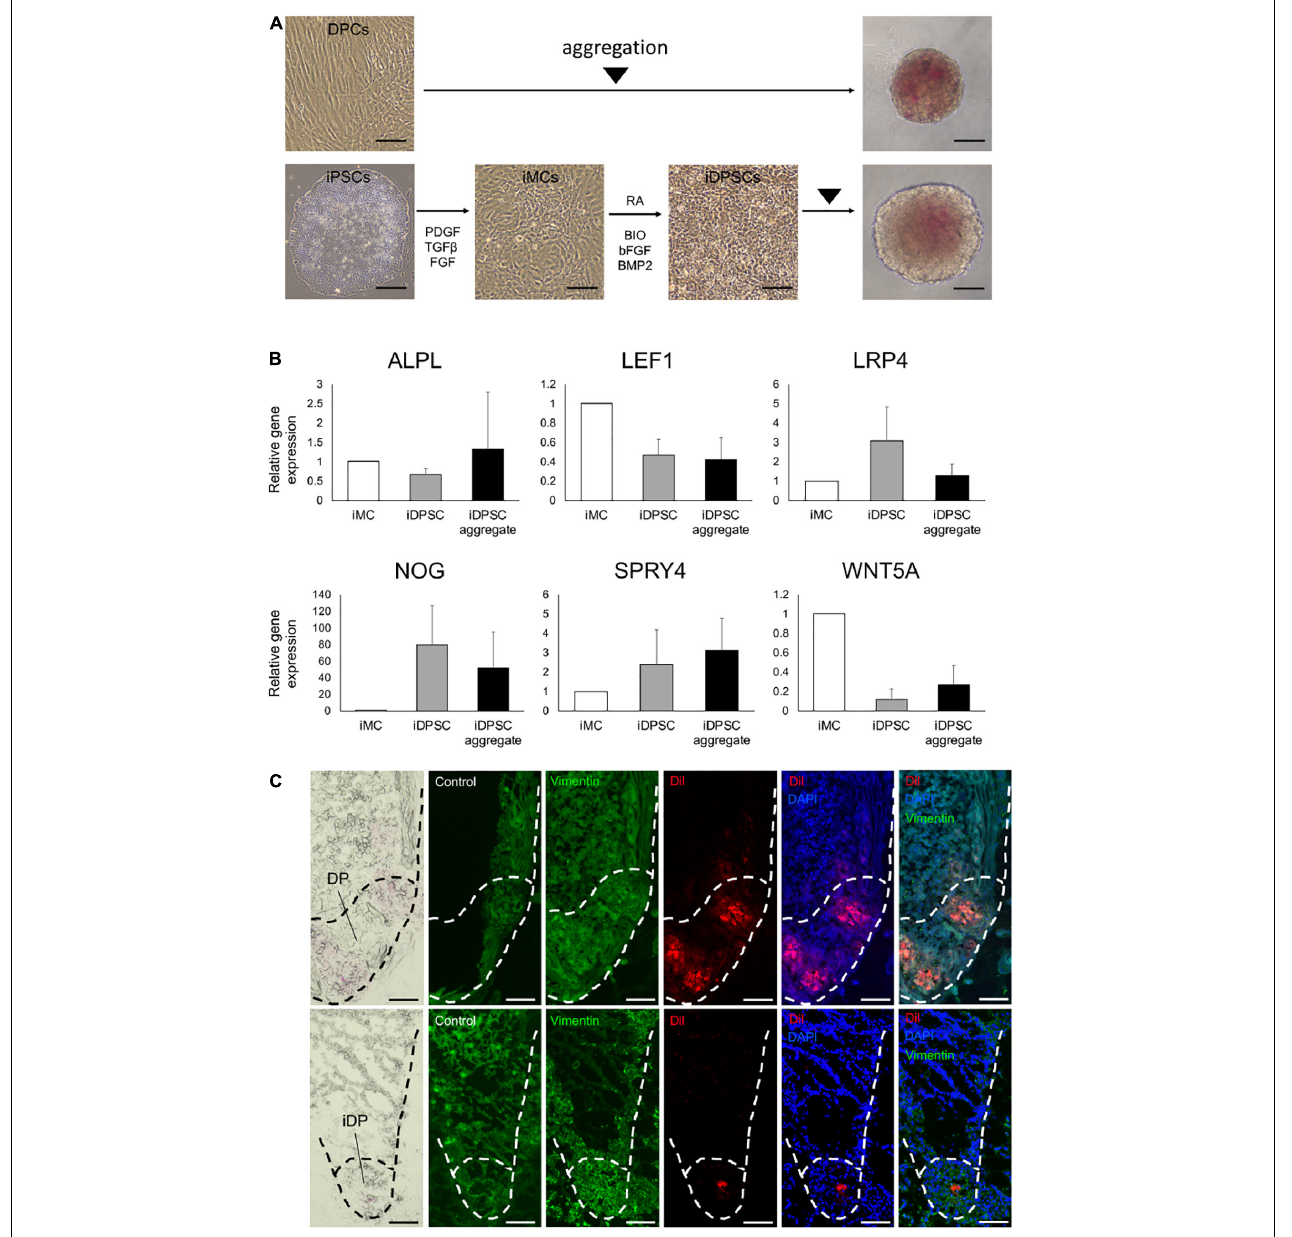
FIGURE 4 | Generation of hiPSC-derived dermal papilla substituting cell aggregates. (A) Aggregation of dermal papilla cells (DPCs) and the stepwise induction of human-induced pluripotent stem cell (hiPSC)-derived DP substituting cells (iDPSCs) from hiPSC-derived mesenchymal cells (iMCs) and the generation of iDPSC aggregates (iDPs). Scale bar: 100 µ m. (B) Change in DP marker gene expression analyzed by qRT-PCR during iDP aggregate preparation from iMCs. (Mean ± SEM; n = 3, triplicate for each experimentation; Wilcoxon signed-rank test). (C) Immunofluorescent images of KC-DP (upper panels) and KC-iDP constructs (lower panels). Low dyeability to cytoplasmic membrane dyes distinguished iDPs from DPs. Scale bar: 200 µ